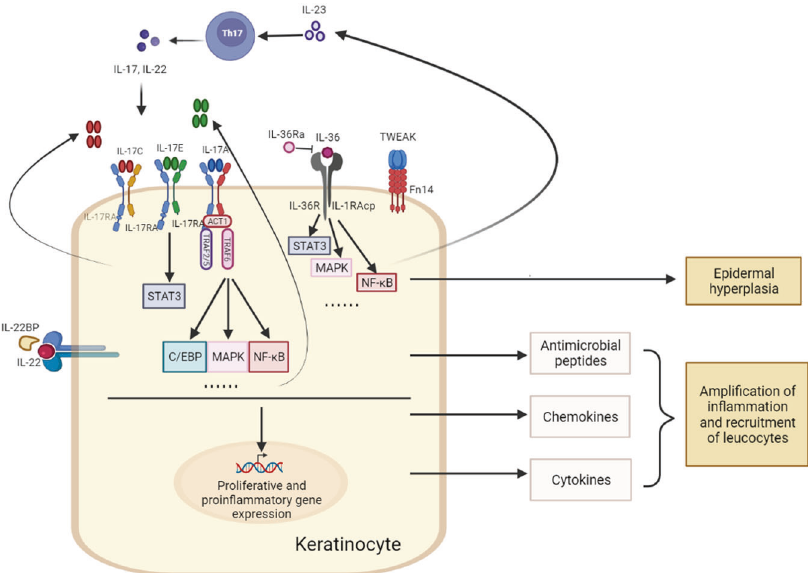
Fig. 2 The role of cytokines derived from or receptors expressed on keratinocytes in psoriasis. Cytokines are essential in the pathogenesis of psoriasis. Recently, cytokines derived from or receptors expressed on keratinocytes have shown great importance in psoriasis. Keratinocytes are critical cytokine responders in psoriasis, as keratinocyte-speci fi c deletion of their receptors (such as IL-17RA and IL-36R) alleviated psoriasiform lesion in psoriatic mouse model. Keratinocyte-derived IL-17C, IL-17E, IL-36, and IL-23 could induce expression of proliferative and proin fl ammatory genes by multiple signaling pathways, leading to epidermal hyperplasia and ampli fi cation of in fl ammation and leukocyte in fi ltration. IL-17RA IL-17 receptor A, TRAF6 TNF receptor-associated factor 6, IL-36R IL-36 receptor, IL-1RAcp IL-1 receptor accessory protein, TWEAK tumor necrosis factor (TNF)-like weak inducer of apoptosis, Fn14 factor-inducible 14, IL-22BP IL-22 binding